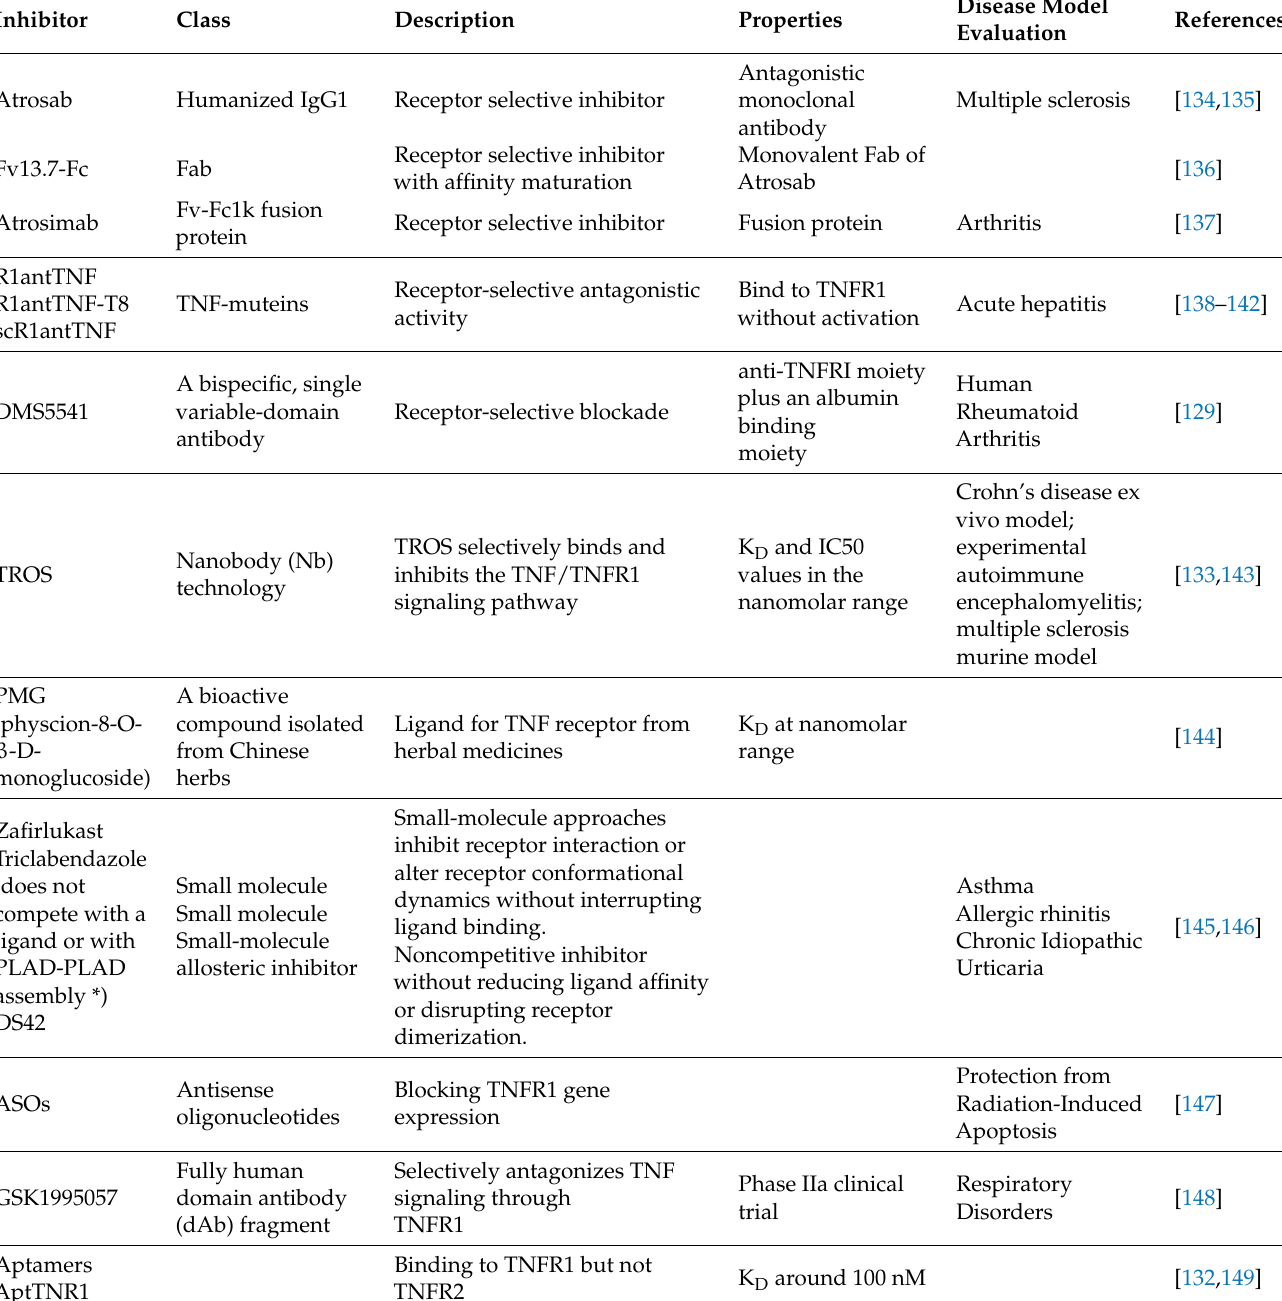
Table 1. Human TNFR1 inhibitors under